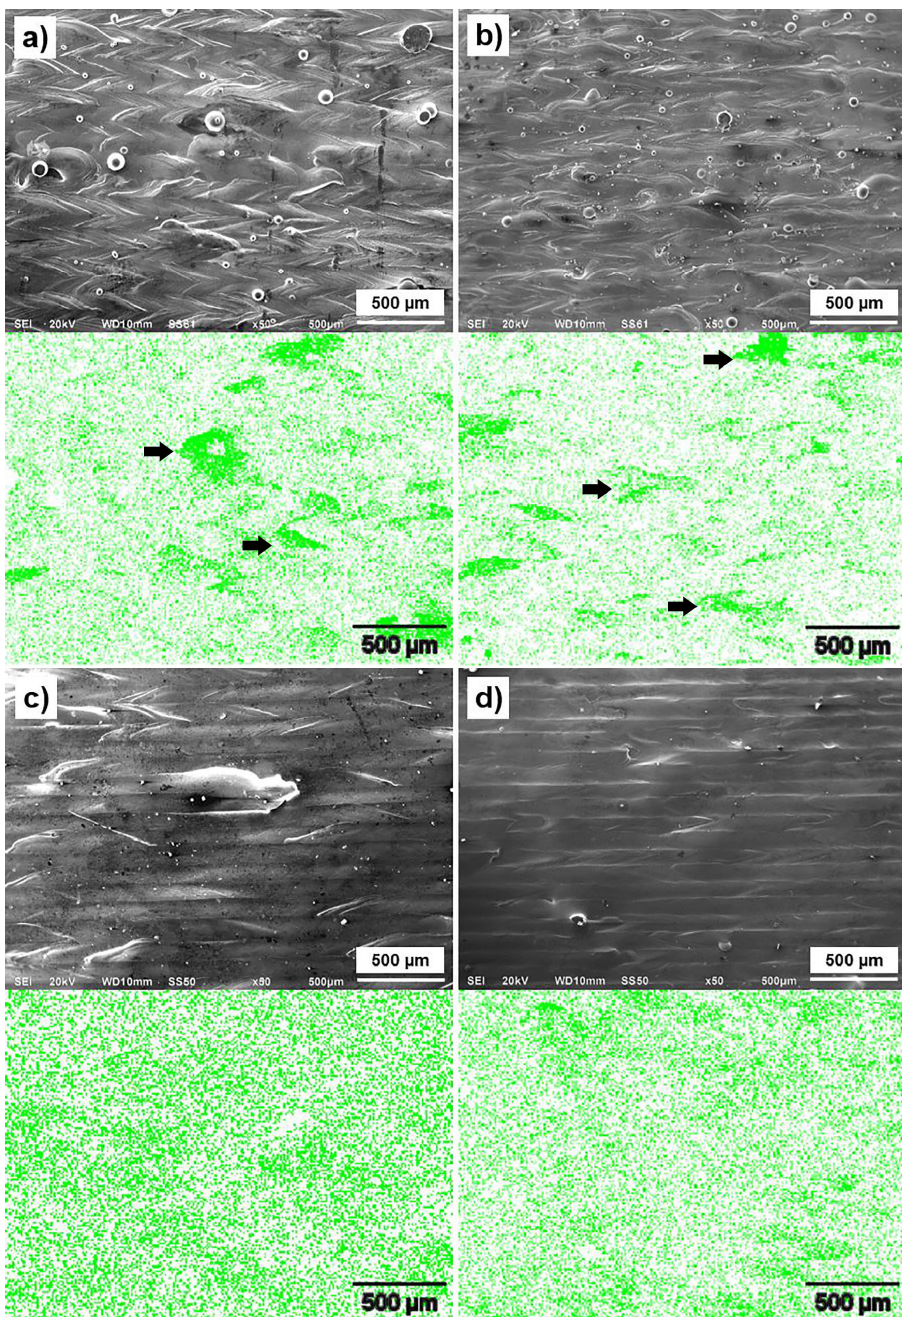
Figure 2. Top view of single layers, and CuK α SEM ‐ EDS maps obtained from the surfaces of LPBF Ti6Al4V (ELI) ‐ 1 at % Cu manufactured at laser power of 170 W and 90 μ m hatch distance: ( a ) single scan strategy, scanning speed 0.7 m/s; ( b ) single scan strategy, scanning speed 1.3 m/s; ( c ) rescan